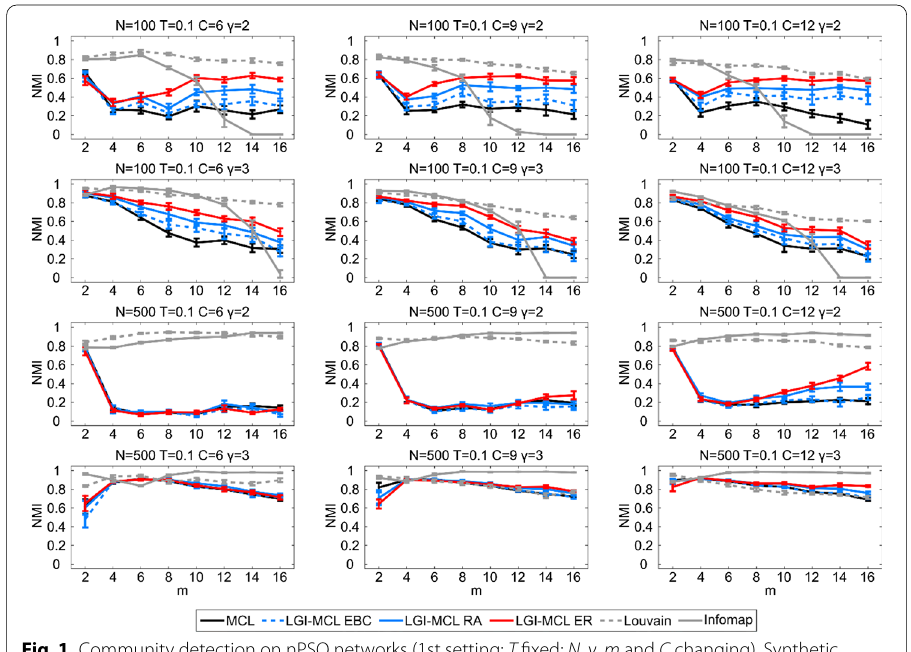
Fig. 1 Community detection on nPSO networks (1st setting: T fixed; N , γ , m and C changing). Synthetic networks have been generated using the nPSO model with parameters N [100, 500] (network size) γ [2, = = 3] (power-law degree distribution exponent), m [2, 4, 6, 8, 10, 12, 14, 16] (half of average degree), T 0.1 = = (temperature, inversely related to the clustering coefficient) and C [6, 9, 12] (number of communities). = For each combination of parameters, 10 networks have been generated. For each network the community detection methods have been executed and the communities detected have been compared to the annotated ones computing the Normalized Mutual Information (NMI). The plots report for each parameter combination the mean NMI and standard error over the random repetitions and show that LGI-MCL, compared to MCL, significantly improves the performance for small N and low T , regardless of γ changes. Instead, for middle-size networks, this is mainly true for large C , large m and low